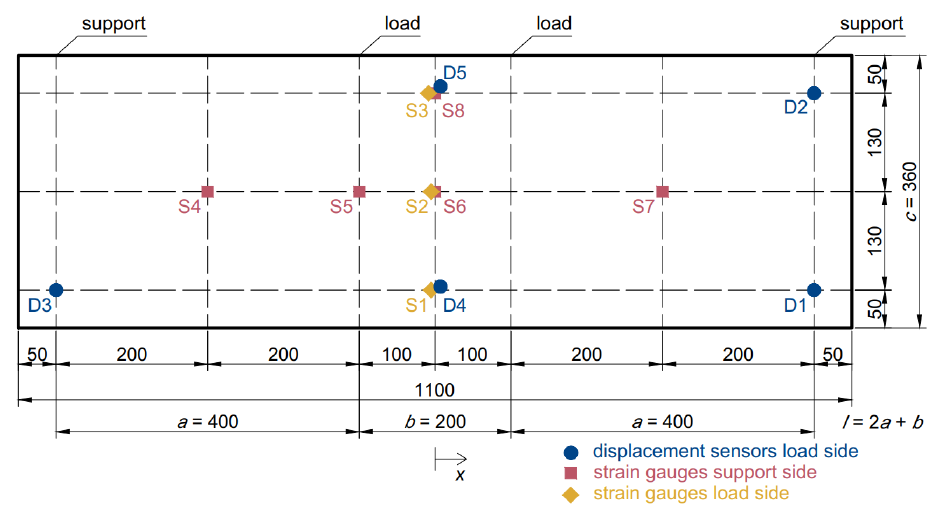
Figure 2. Setup of the four-point bending